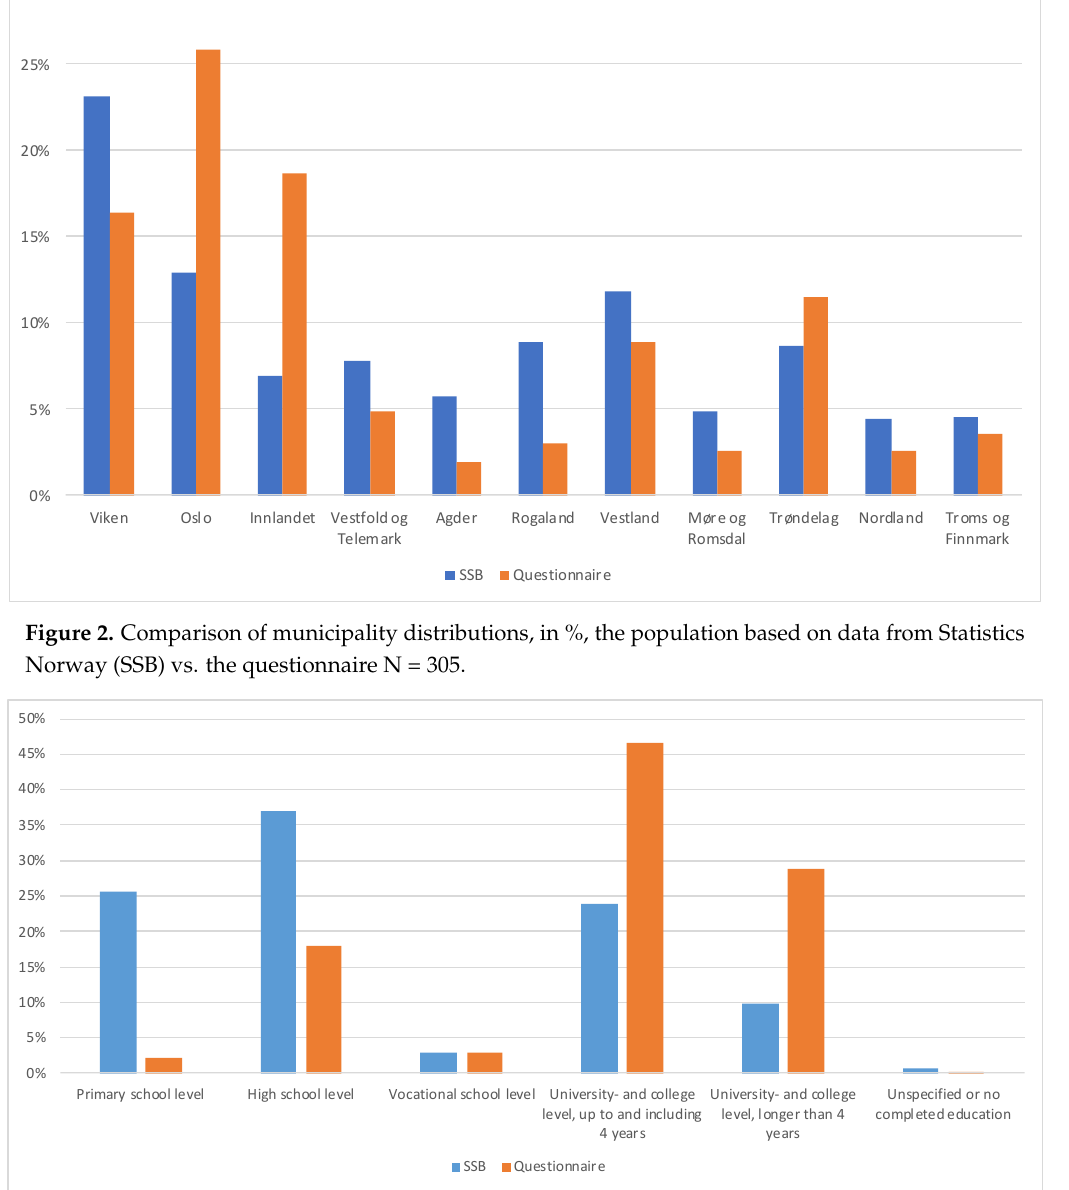
Figure 3. Comparison of education distributions, in %, of the Norwegian population based on data from SSB vs. the questionnaire N =